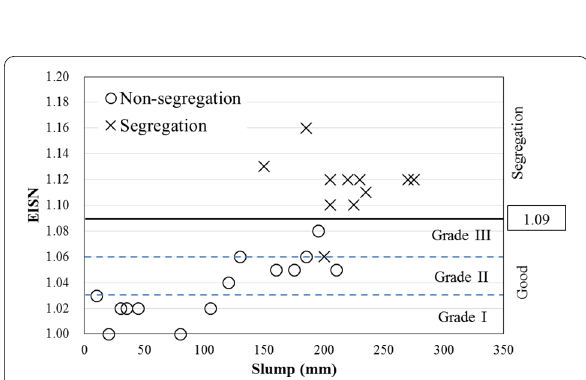
Fig. 8 Categorizing grades of concrete mixtures depending on EISN for normal concrete mixture.